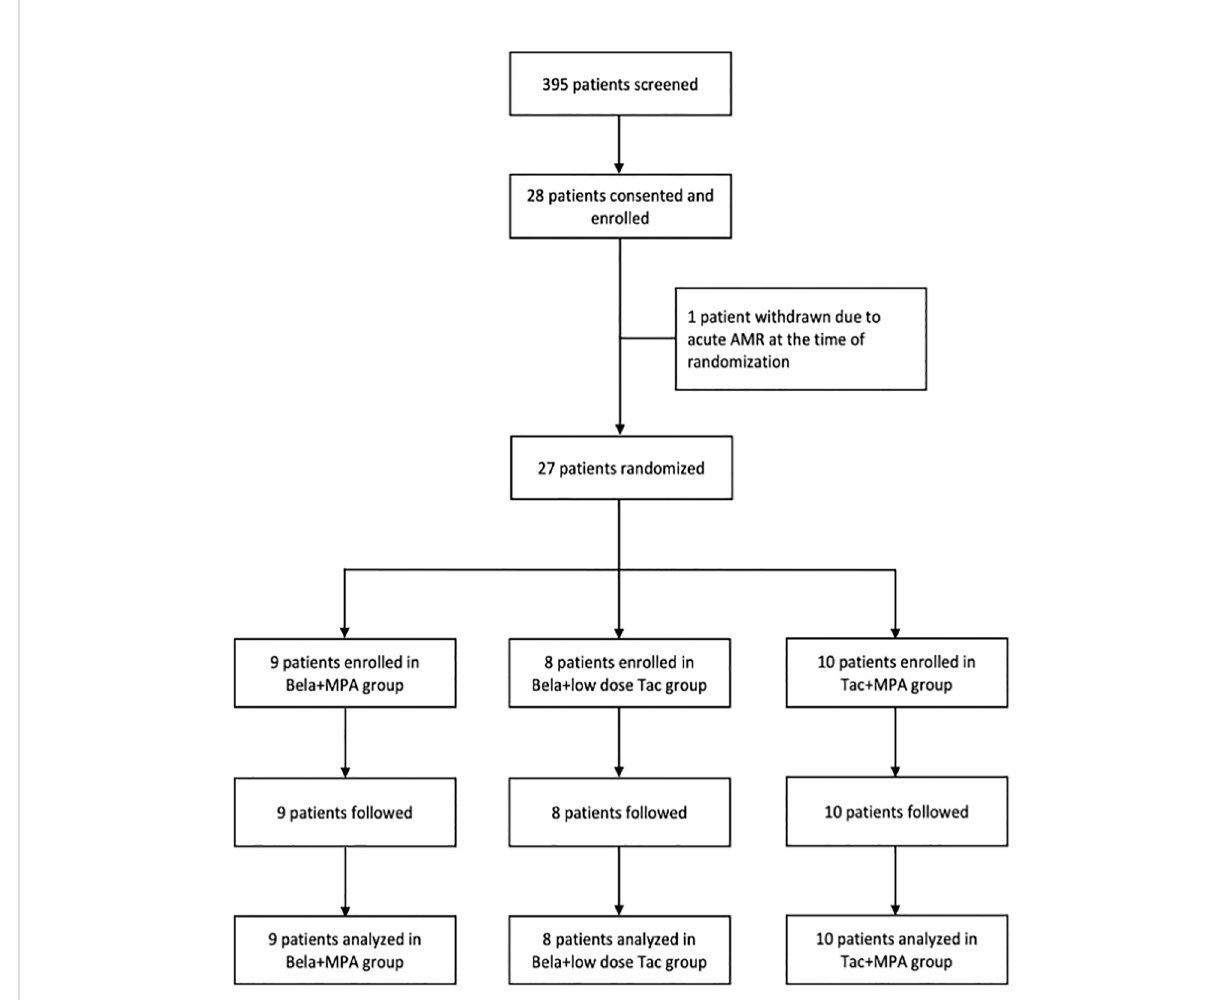
FIGURE 1 CONSORT diagram. The diagram shows the fl ow of patients through the study. Twenty seven patients were randomized at 3 months post kidney transplantation to undergo conversion to Bela+MPA (n= 9), Bela+Low dose Tac (n= 8), or continuation of Tac+MPA. The outcomes were analyzed and compared between groups using intention-to-treat (ITT) analysis